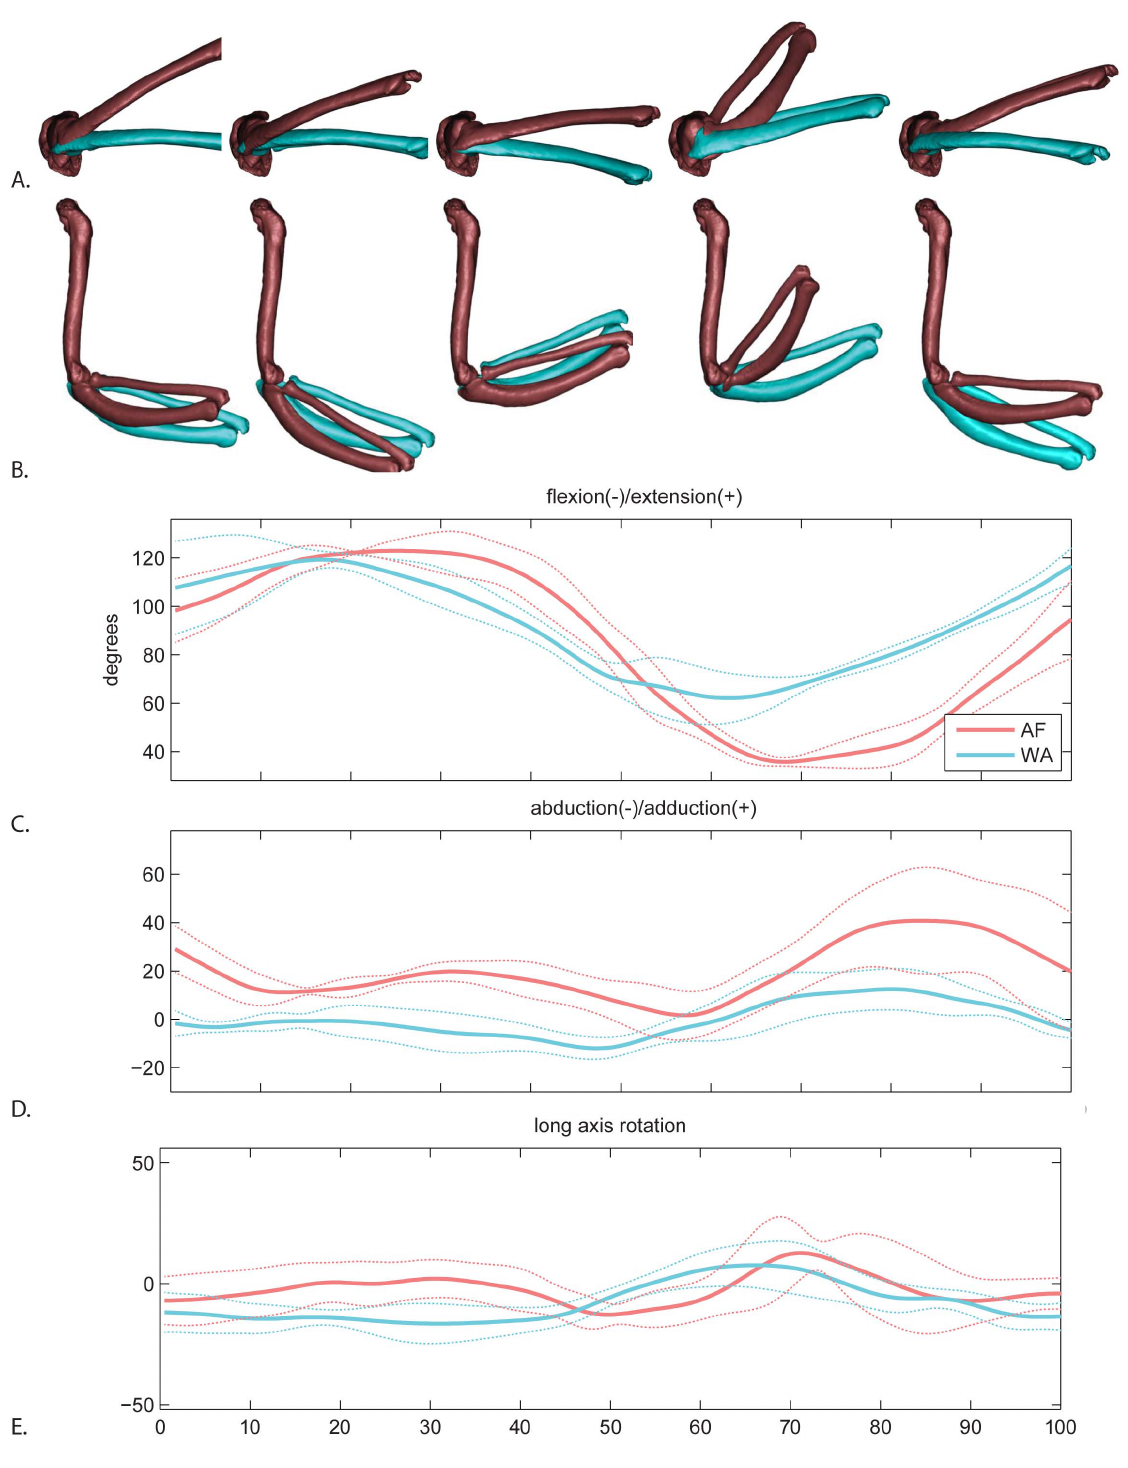
Figure 7. Elbow motion. A. lateral view and B. dorsal view of average AF (red) and WAIR (blue) wingbeats at 0, 25, 50, 75 and 100% of the cycle. Ulna and radius shown relative to a fixed humerus. C–E. mean and standard deviations for each rotational degree of freedom. Time scale 0 to 50%=downstroke, 50–100%=upstroke. doi:10.1371/journal.pone.0063982.g007 looking from dorsal view, wrist extension produces movement in 90 6 17.8; WAIR 48.2 6 15.4). The wrist extended to a much the same plane as elbow extension. greater degree during downstroke in AF and maintained the extension well into upstroke, whereas the wrist began flexing much The largest difference in wrist motion between AF and WAIR earlier in the wingbeat during downstroke of WAIR (as with the was total magnitude of flexion/extension (Fig. 8C; Range: AF